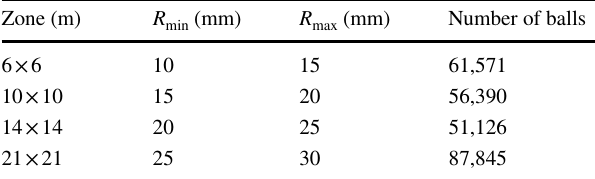
Fig. 3 Model diagram. Note: the green line represent the joints Table 1 Particle size table of different regions of the model